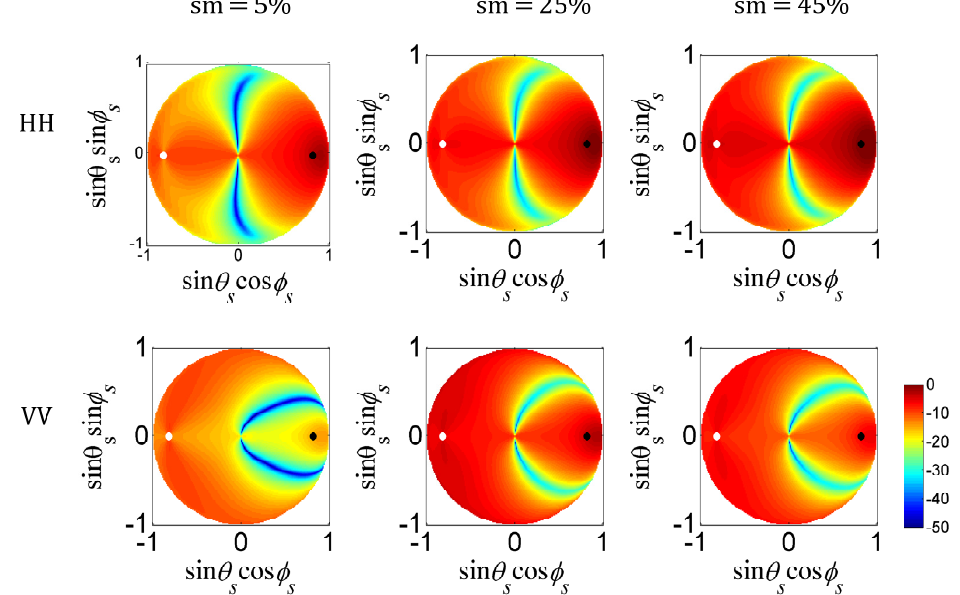
Figure 3. Patterns of bistatic scattering coefficients for changing the soil moisture (5%, 25%, and 45%) for relatively rough ( 𝑠 = λ/3) surface.